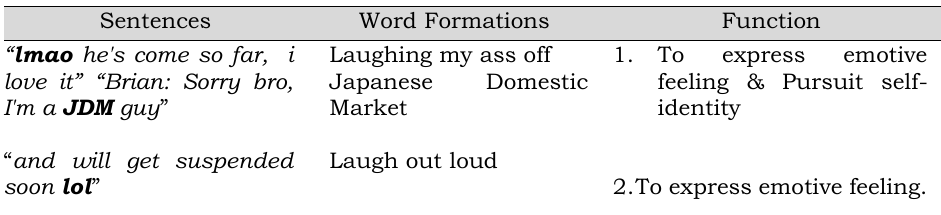
Table 4. Acronym word-formation